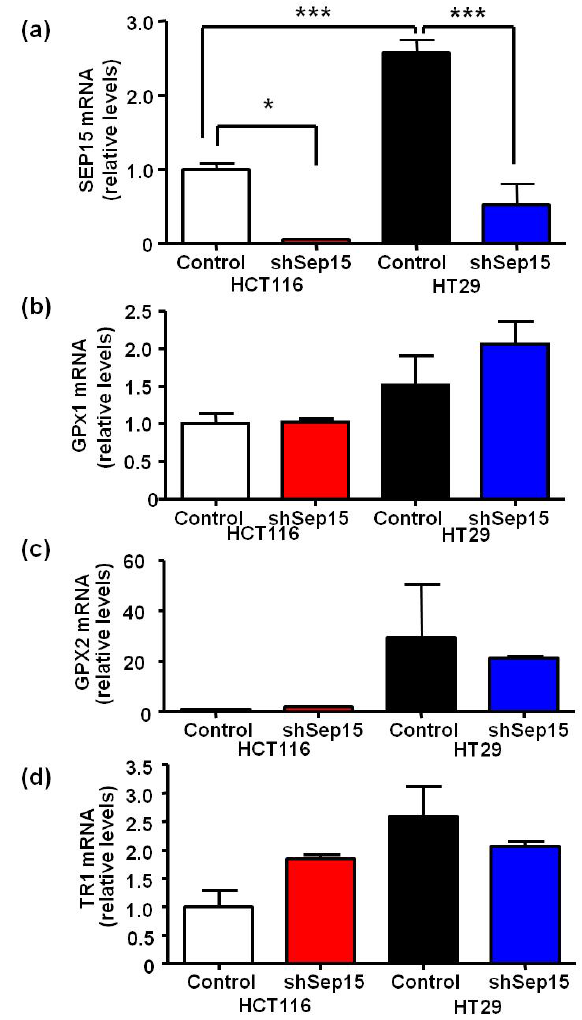
Figure 1. mRNA expression of selenoproteins in Sep15 deficient human colorectal cancer cells. mRNA levels of ( a ) Sep15, ( b ) GPx1, ( c ) GPx2 and ( d ) TR1 were measured using quantitative real-time RT-PCR, and GAPDH was used as an internal control. Data are displayed as means ± SE (ANOVA, n = 3) and were graphed relative to expression in HCT116 control cells (cycle threshold values were 17.6, 20.1, 19.6, 29.7 and 23.5 for GAPDH , SEP15 , GPX1 , GPX2 and TR1 , respectively).